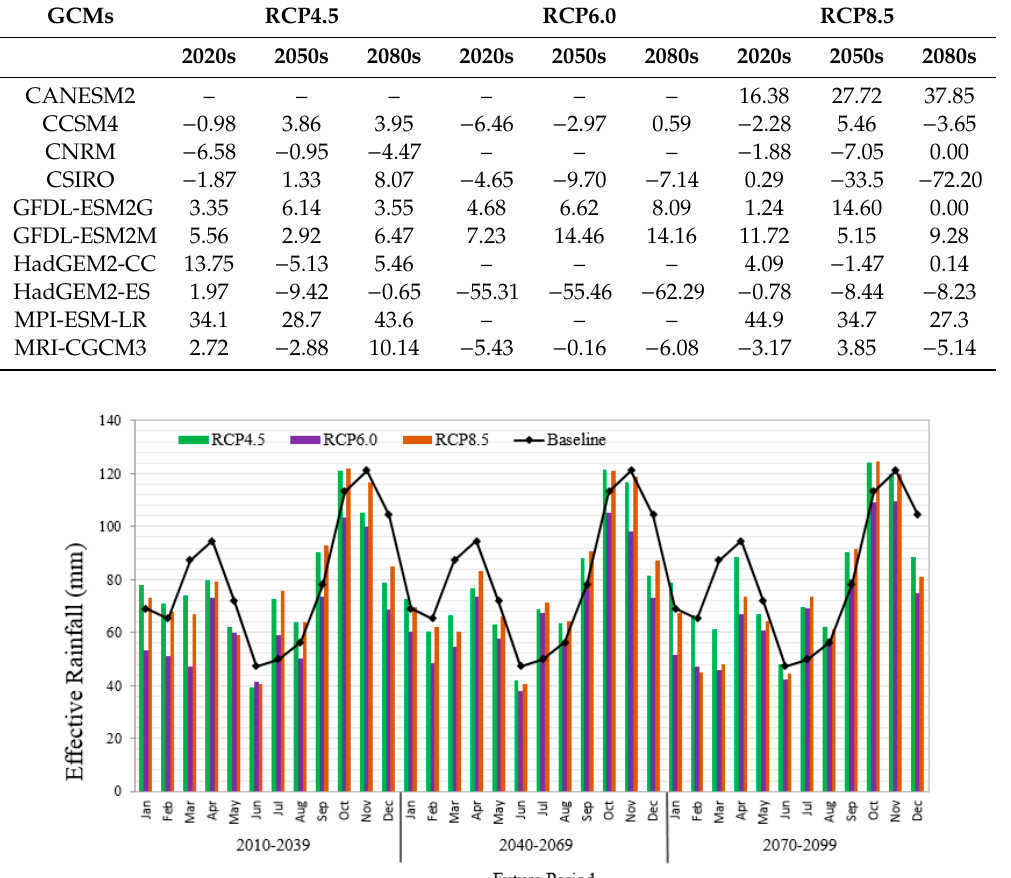
ff ective rainfall using multiple models under RCPs 4.5, Figure 3. Projected average monthly effective rainfall using multiple models under RCPs Figure 3. Projected average monthly e